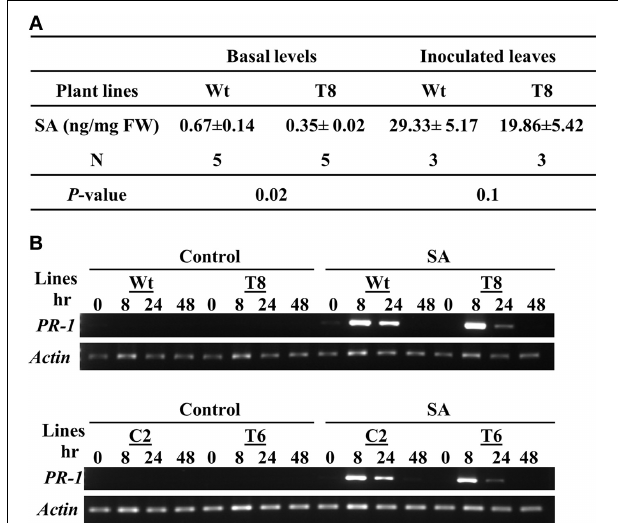
FIGURE 4 | InsP 5-ptase plants have a low basal level of SA; however the local response to exogenous SA is normal. (A) SA levels were measured in untreated leaves (basal) or in leaves harvested from plants inoculated with Pst DC3000 + avrRpt2 at a concentration of OD 600 = 0 . 1 (1 × 10 8 cfu/ml) at day 2 post-inoculation. Data is the average of three to five experiments ± SE. Each experiment consisted of a pool of leaves from four individual plants/line. (B) Wild type (Wt), two independent InsP 5-ptase lines (T6 and T8), and vector control (C2) plants were sprayed with 300 μ M of SA or control solution (0.05% ethanol). Leaves were harvested before (0) and at 3, 8, 24, and 48h after treatment. RT-PCR was carried out with gene-specific primers for PR-1 and Actin .